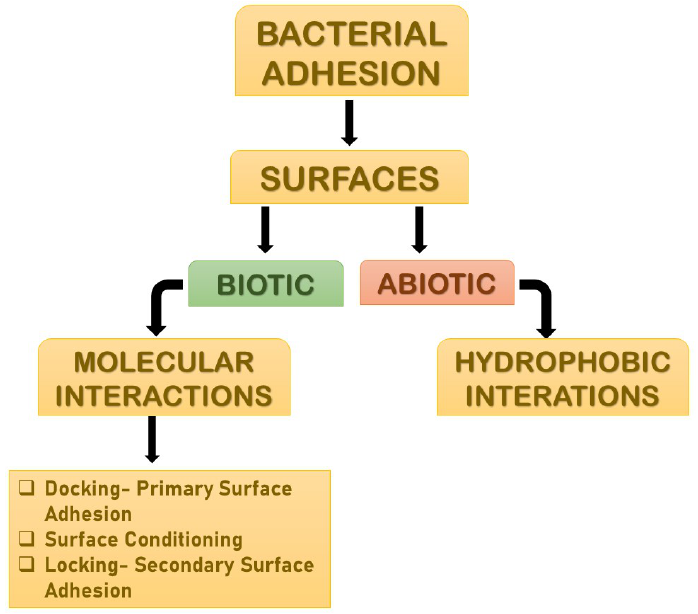
Figure 3. The distinct phases of adhesions. They are mainly primary or reversible adhesion and secondary or irreversible adhesion. These phases are completely controlled by the different expressions of the genes. The reason behind this feature of surface adherence in bacteria is because the concentration of the nutrients is higher near the solid surfaces. This feature of bacteria plays out in two ways, and either can be beneficial or disastrous .